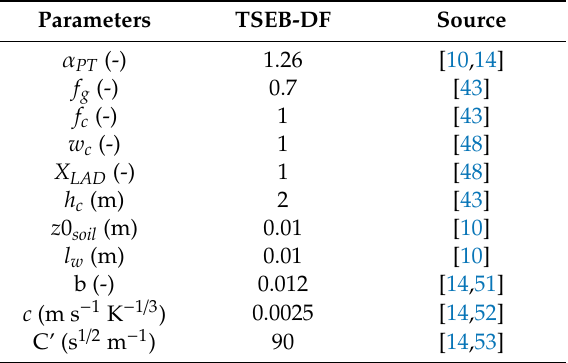
Table 2. Parameter values of the TSEB-DF model